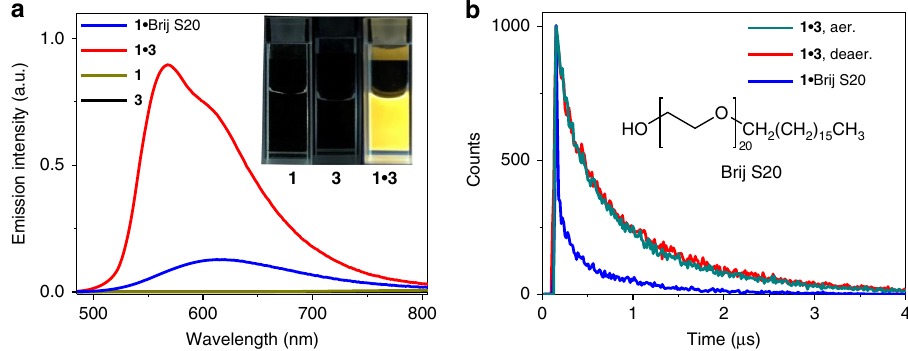
Fig. 4 Emission characterization of 1 (cid:129) 3 . a Emission spectra of 1 , 3 , complex 1 (cid:129) 3 and complex 1 (cid:129) Brij S20 in water/MeOH (90:10, v / v ) (1.00mM for Brij S20 and 0.05 mM for other compounds). Inset: Emission color images of 1 , 3 , and complex 1 (cid:129) 3 under 365 nm ultraviolet lamp. b Emission decay traces of the aerated (dark cyan line) and deaerated (red line) samples of complex 1 (cid:129) 3 , together with the deaerated sample of complex 1 (cid:129) Brij S20 in water/methanol (90:10, v / v ) (1.00 mM for Brij S20 and 0.05 mM for other